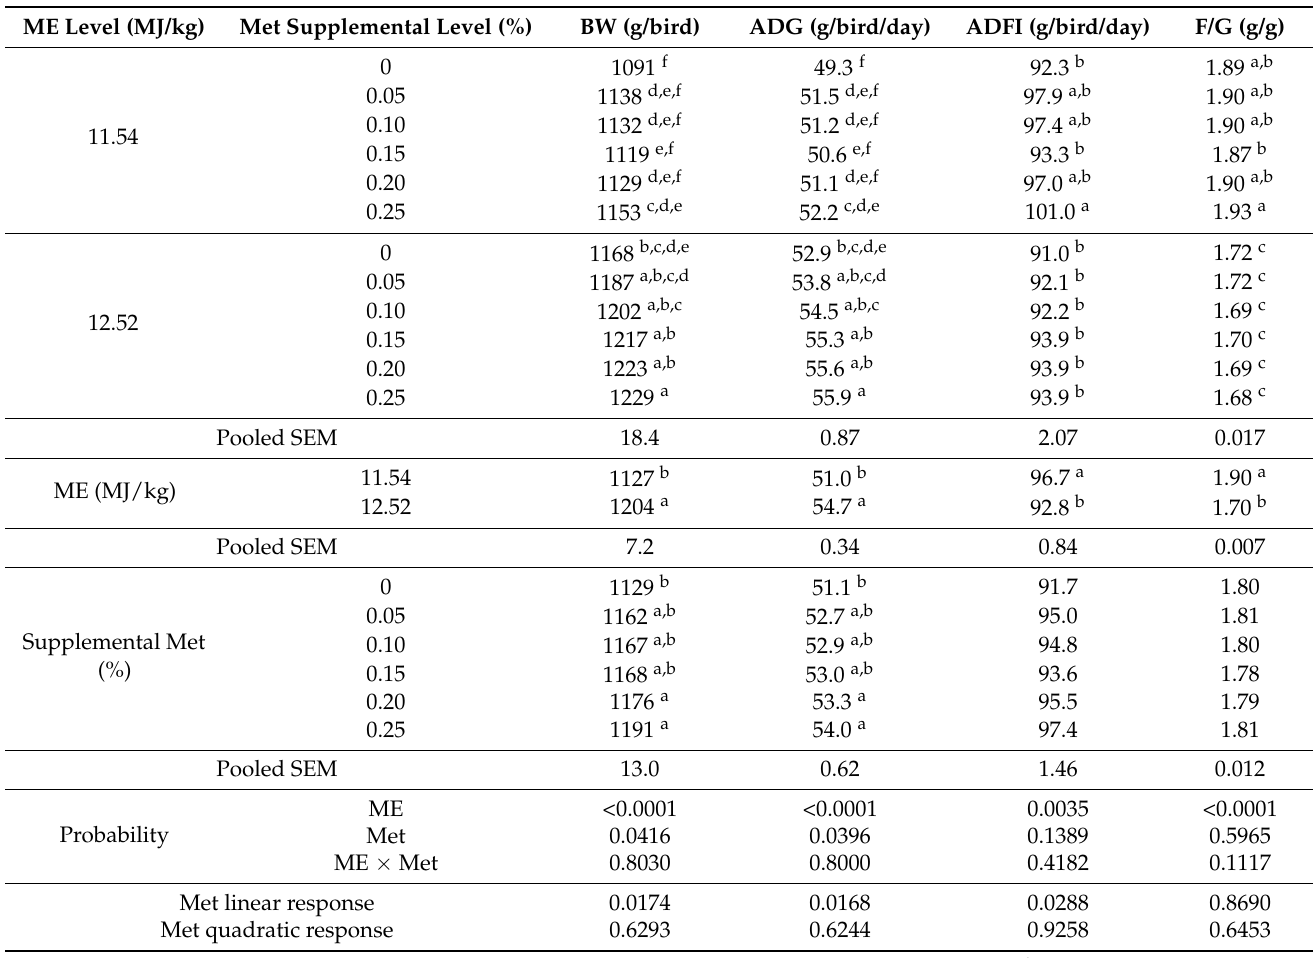
Table 2. Effects of dietary metabolizable energy and methionine levels on growth performance of starter Pekin ducks from 1 to 21 days of age 1,2